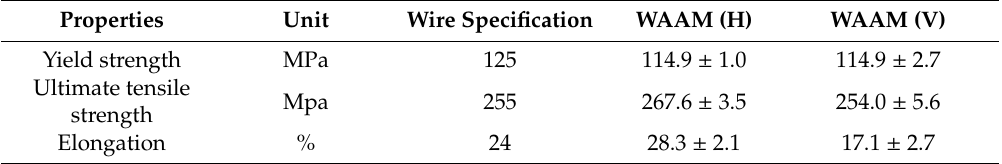
Figure 7. Tensile properties of processed Al-5356 in ( a ) horizontal and ( b ) vertical directions. Table 3. Mechanical properties determined from additive manufacturing (AM)-processed Al-5356.